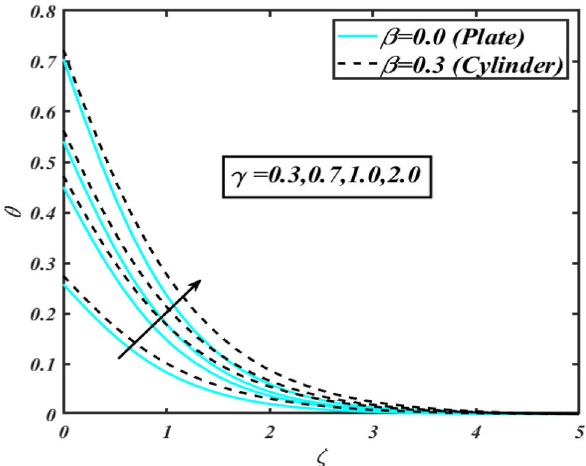
Figure 9. Profile of θ for γ .